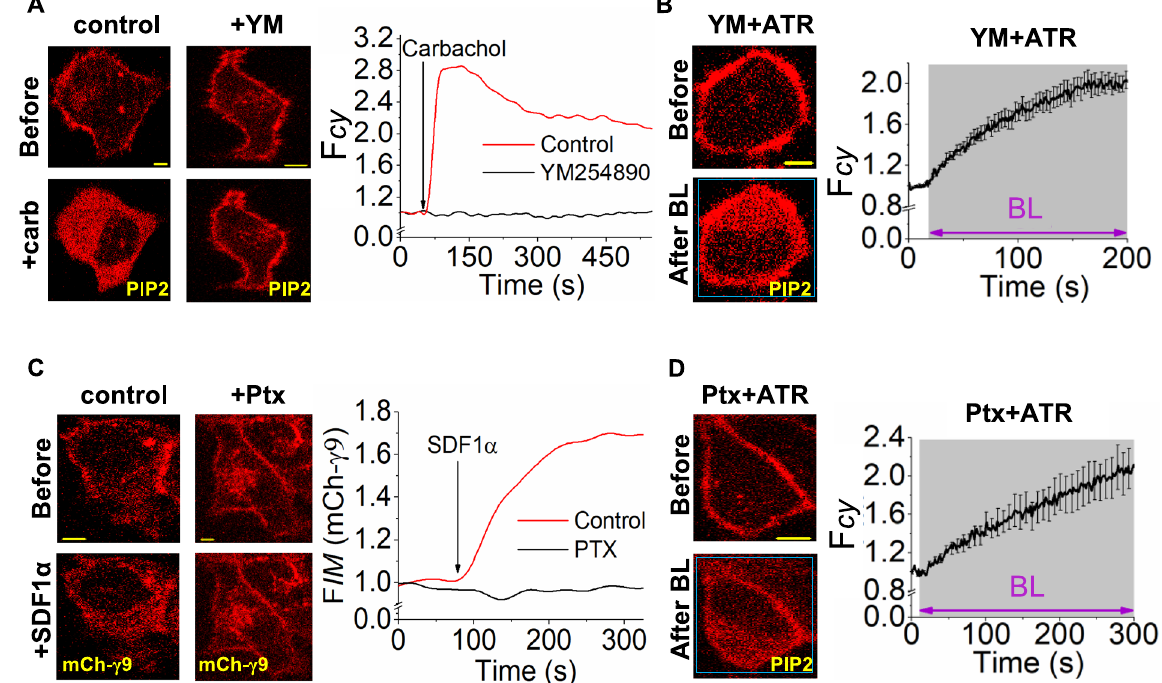
Figure 5. Photoexcited retinal induced PIP2 translocation is not due to GPCR pathway activation. ( A ) HeLa cells expressing M3 receptor and mCherry-PH, carbachol (10 µ M) was added to activate M3R in the presence (left) and absence (middle) of Gq inhibitor (YM254890, 1 µ M, 5 min). Only control cells (no YM254890), showed PIP2 hydrolysis (left). ( B ) Even in the presence of Gq inhibitor, blue light excited retinal induced PIP2 sensor translocation (middle). The plots show the dynamics of PIP2 sensor translocation in the cells shown in A and B. ( C ) To HeLa cells expressing CXCR4-GFP, mCh- γ 9, SDF1 α (100 ng/mL) was added to activate CXCR4 in the presence (left) and absence (middle) of G α i inhibitor (pertussis toxin = Ptx, 50 ng/mL, overnight incubation). Only control cells with no added Ptx exhibited mCh- γ 9 translocation from PM to IMs (left). ( D ) Exposure to photoexcited retinal induced PIP2 sensor translocation in cells treated with Ptx. The plots show the dynamics of mCh- γ 9 and PIP2 sensor translocation. In all the experiments conducted, cells were exposed to 4.86 µ W of 445 nm blue light. (mean ± S.E.M., n = 5–10 cells). Mean and S.E.M. are from 3 < independent experiments. (blue light (BL) = blue box). Scale = 5 µ